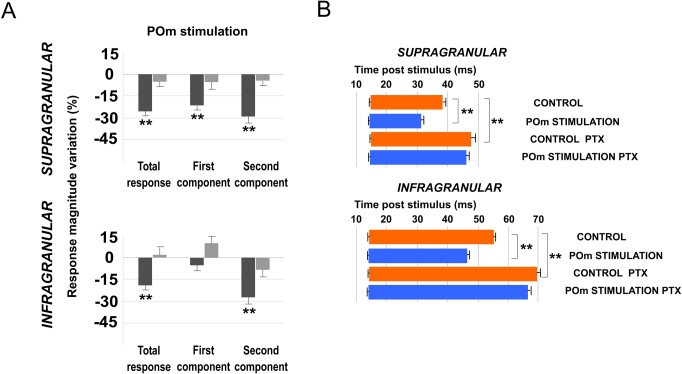
POm E-stimulation before whisker stimulus does not decrease cortical response magnitude and duration when PTX is applied in L1.(A) Percentage change in mean response magnitude by POm E-stimulation before (black) and after PTX application (grey). POm E-stimulation did not decrease cortical response magnitude when GABAergic inhibitory transmission in L1 was blocked. (B) PTX application in L1 increased whisker offset response latency in infra- and supragranular layers. POm E-stimulation before whisker stimulus did not decrease cortical response duration when PTX was applied in L1. Control (orange) and POm E-stimulation (blue) conditions are shown.